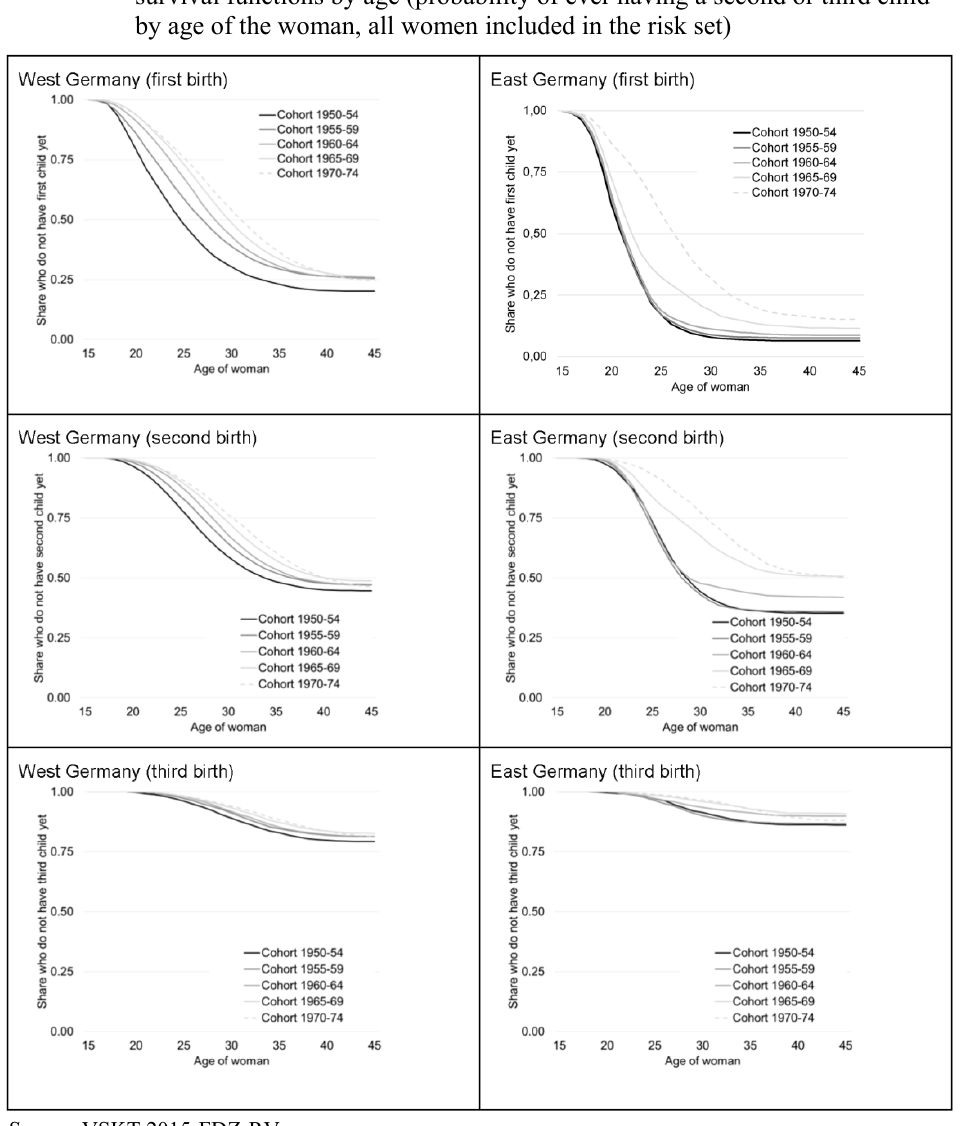
Figure 4 : Progression to the first, second, and third child by groups of birth cohorts, survival functions by age (probability of ever having a second or third child by age of the woman, all women included in the risk